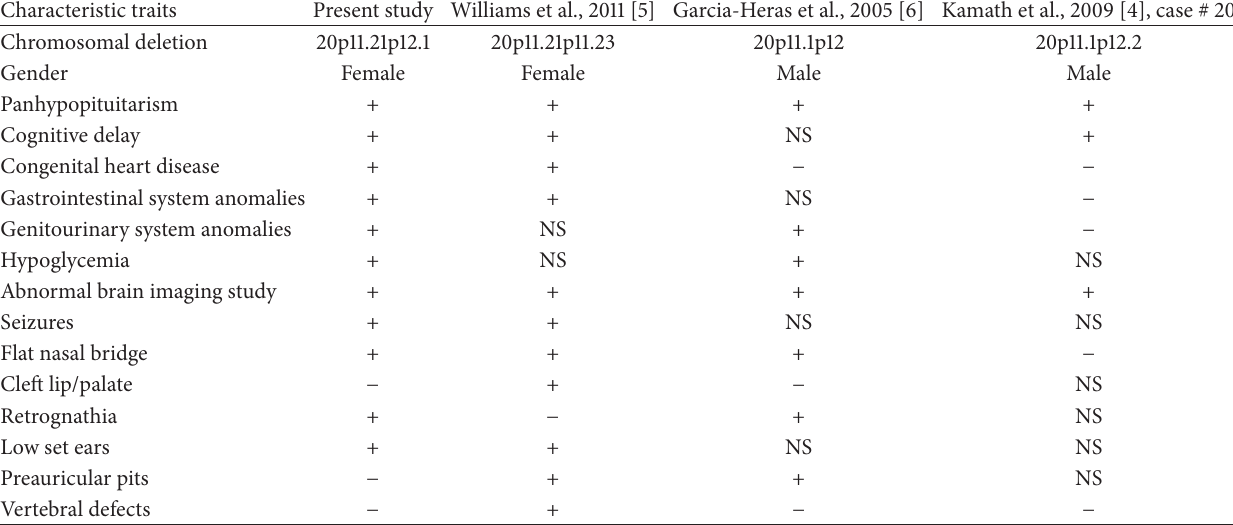
Table 1: Clinical features in patients with panhypopituitarism and interstitial deletions of 20p11 overlapping regions. Characteristic